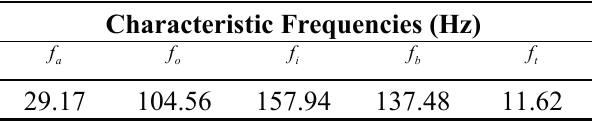
Table 4. Characteristic frequencies of rolling element bearing 6205-2RS JEM SKF (Hz).